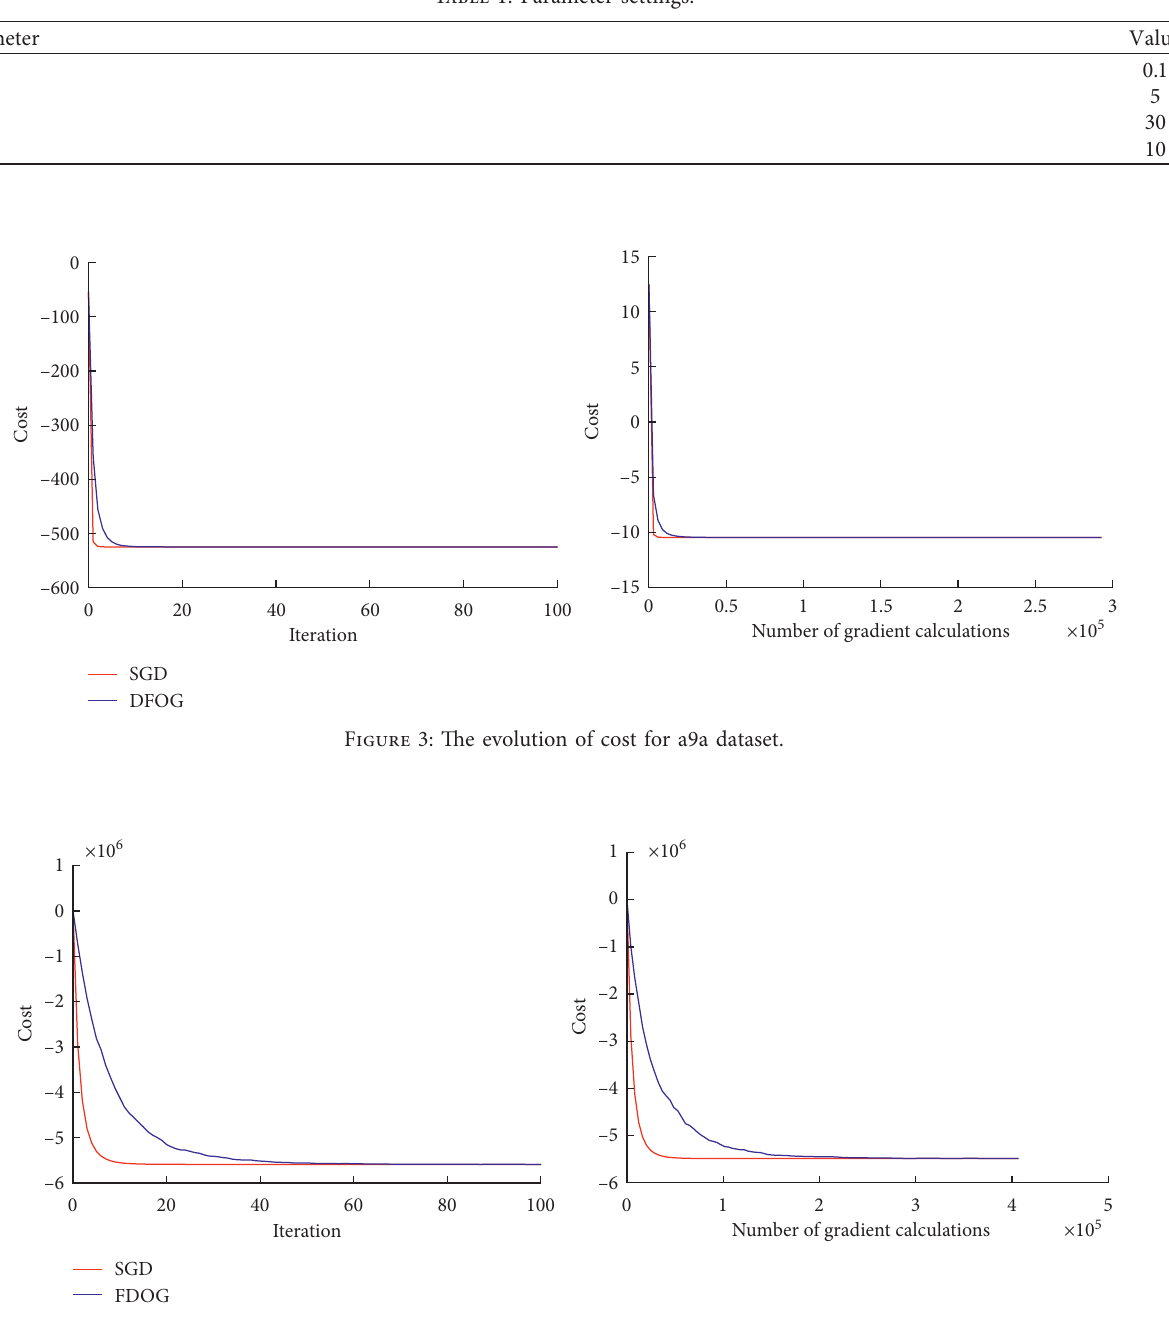
Figure 4: The evolution of cost for bank